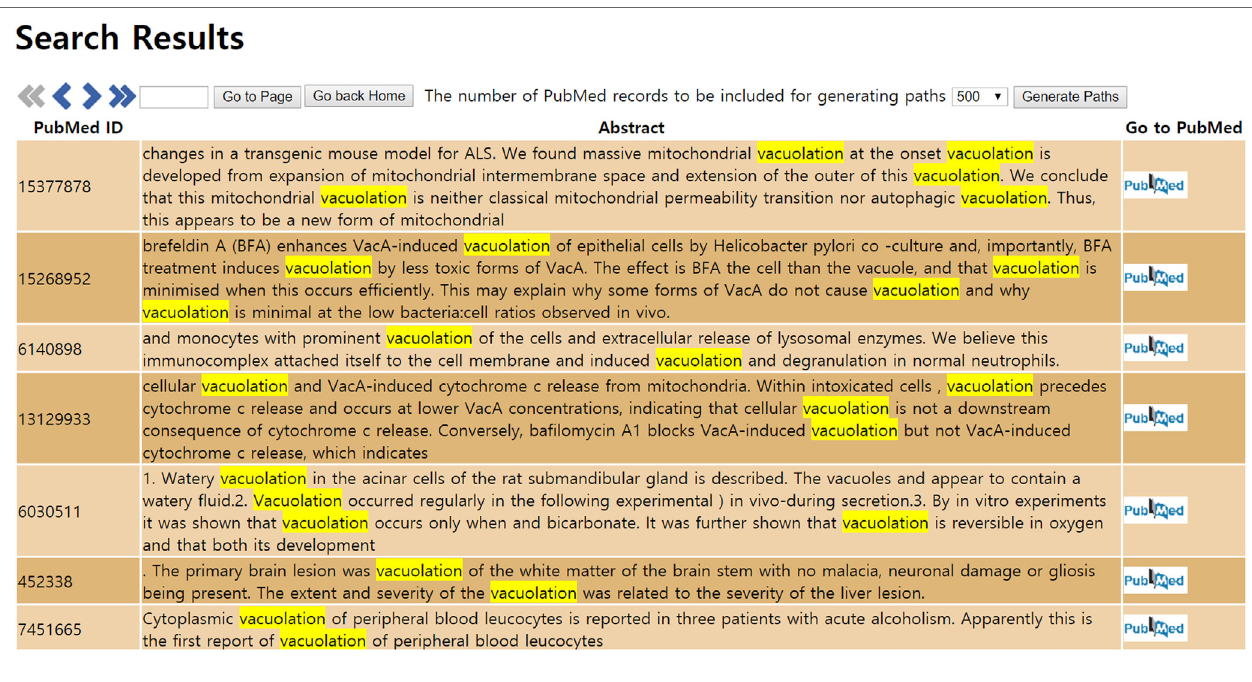
FigUre 13 | Search result page of the hypothesis generator system.